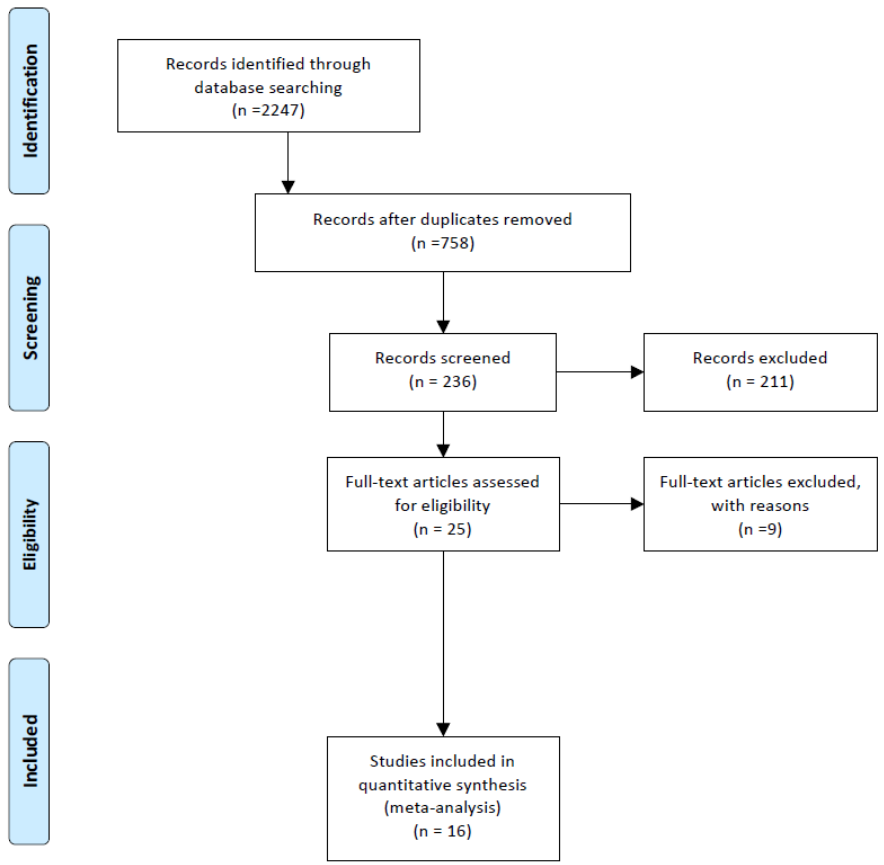
Figure 1. A flowchart of the literature screening performed in this study.